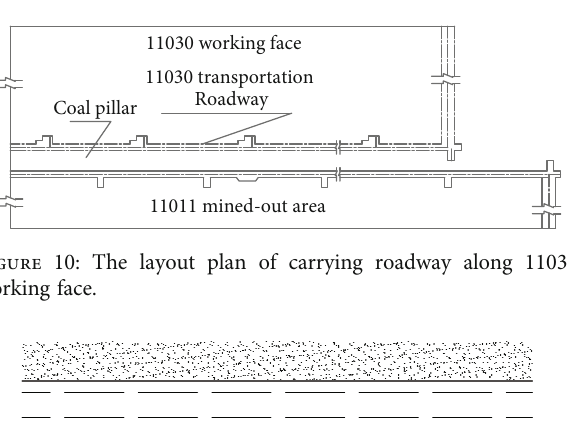
Figure 9: Formation mechanism of coal pillar width e ff ect.